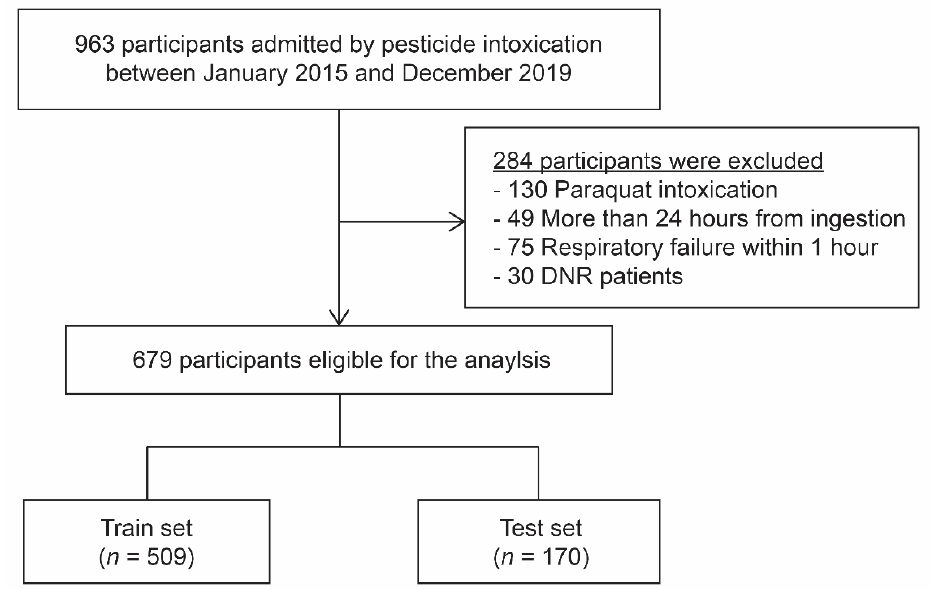
Figure 1. Flow diagram of the study inclusion and exclusion criteria.